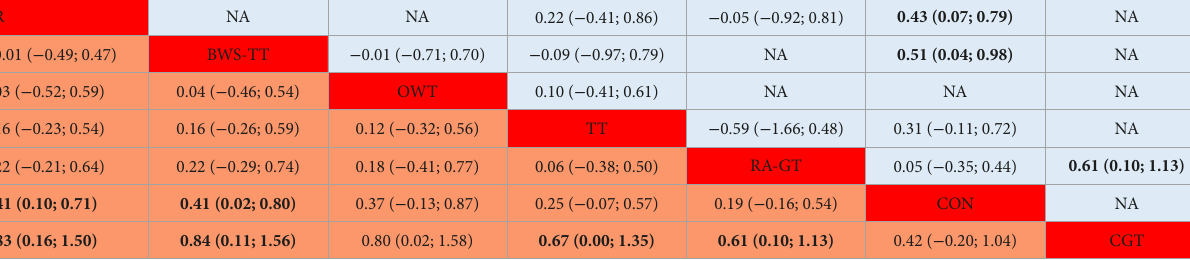
Bold values mean significant difference. Blue means relative degree of direct comparison between gait training. Light red means relative degree of combined comparison between gait training. Deep red means gait training. TT, treadmill; BWS-TT, body-weight-supported treadmill training; RA-GT, robot-assisted gait training; VR, virtual reality gait training; CGT, conventional gait training; OWT, overground walking training; CON, control